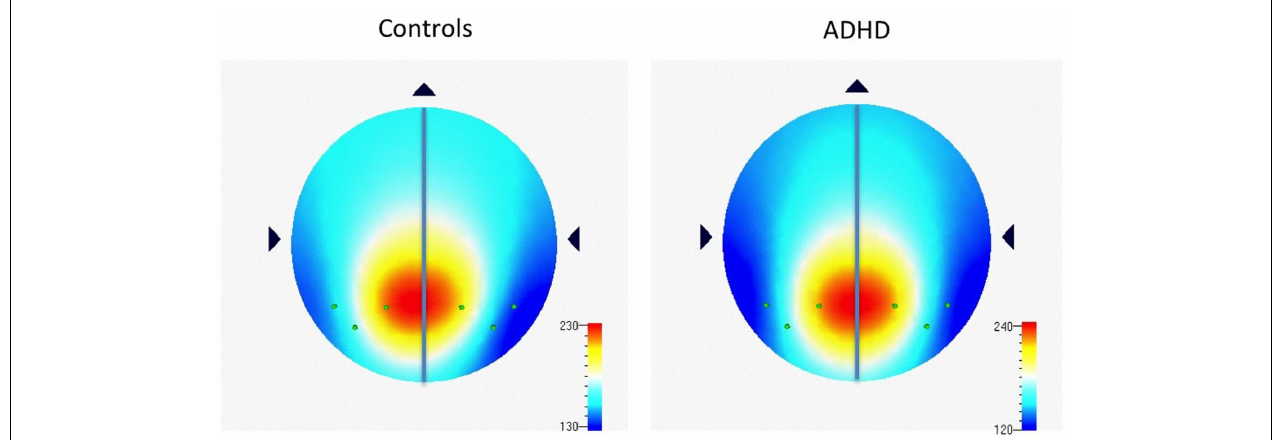
spread of beta2 (16–21Hz) power ( µ v 2 ) among parietal electrodes comprising parietal asymmetry indices (TP7, P7, P3,TP8, P8, P4). Note the leftward distribution of power in controls compared to